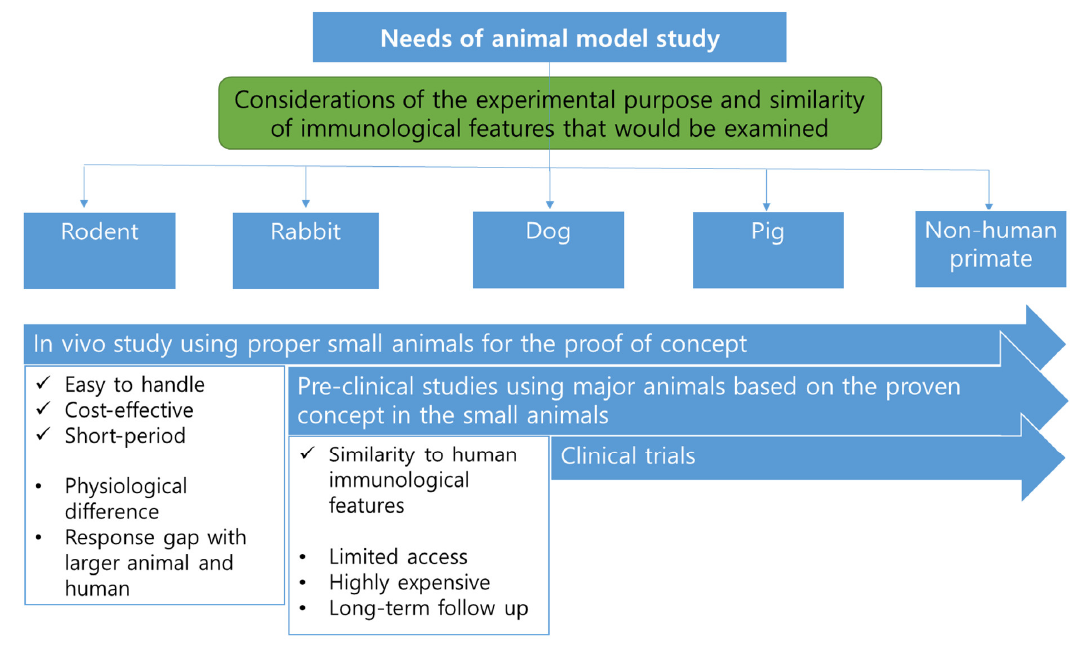
Figure 1. The need for animal study and selection of proper animals.